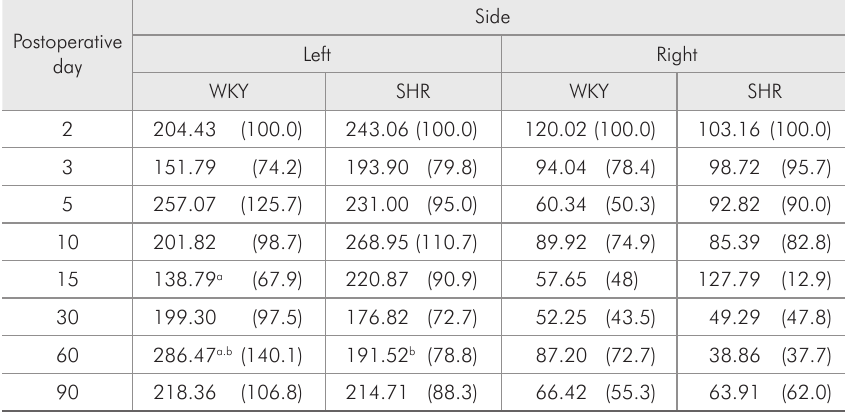
Figure 4 - Progression of the defect area across the postoperative days. The tendency lines of the 2 mm defect show similar bone closure behavior between the two strains. On the other hand, the 5 mm defect of the WKY strain seems to increase, but its final value is similar to that of the SHR strain.